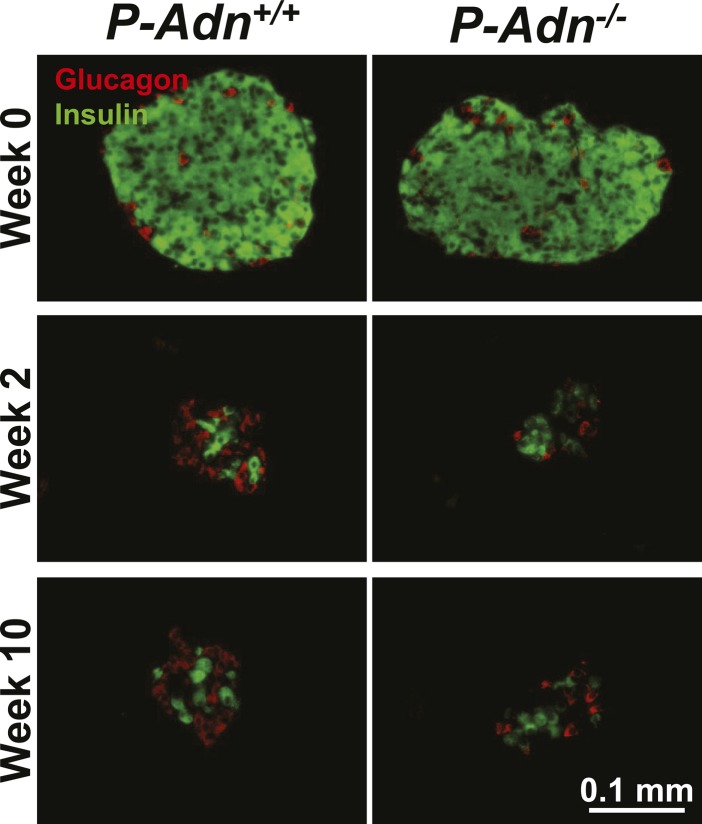
Sustained β-cell ablation in PANIC-ATTAC mice.Representative immunofluorescence of glucagon (red) and insulin (green) on pancreatic islets from homozygous PANIC-ATTAC with adiponectin wild-type (P-Adn+/+) or knockout (P-Adn−/−) mice at 0, 2, and 10 weeks after dimerizer treatment. Related to Figure 1A.